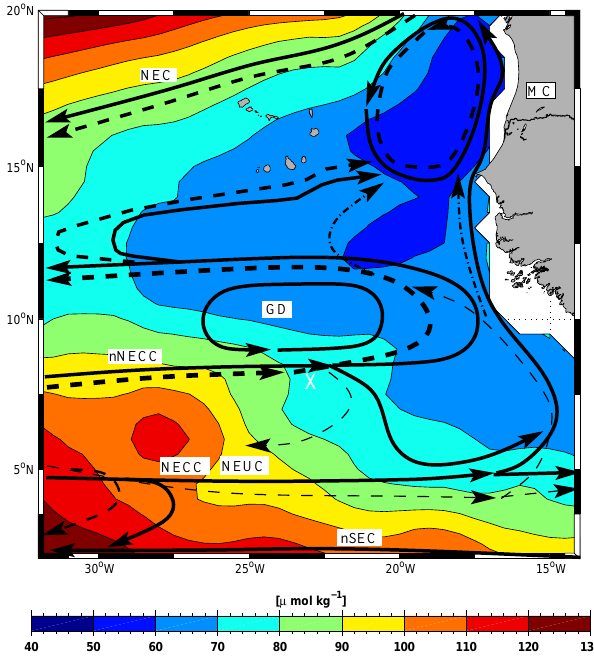
Figure 12. Schematic flow field based on the results from this investigation and on earlier schematics (e.g., Mittelstaedt, 1983; Stramma and Schott, 1999; Stramma et al., 2008b; Peña-Izquierdo et al., 2012; Brandt et al., 2015) shown as solid black lines for the upper ocean to about 200m depth and as dashed black lines for the layer 200 to 400m. The two dash-dotted lines indicate possible dif- ferent paths of the 200 to 400m layer; thin lines indicate weak or reversing currents. For current names please refer to the text. The white cross at ∼ 8 ◦ N, 23 ◦ W marks the location of the tracer re- lease. Annual mean climatological oxygen distribution (color) at 350m depth from CARS 2009 climatology (Ridgway et al.,